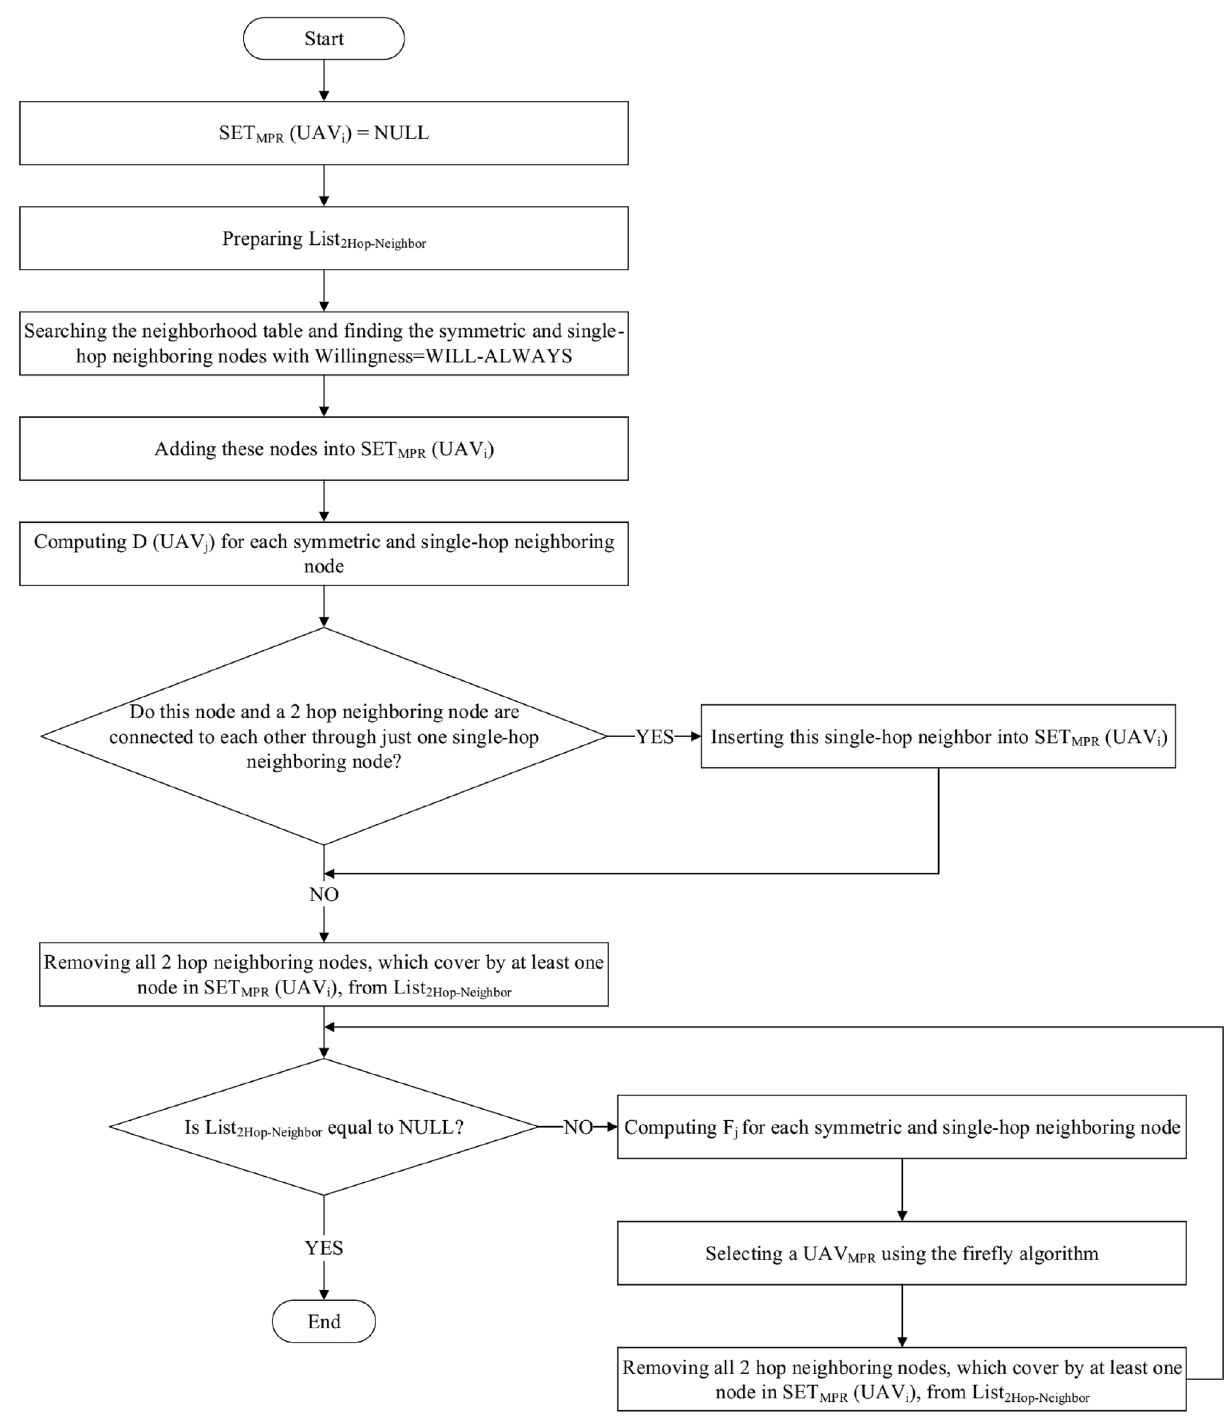
Figure 4. Flowchart of MPR node